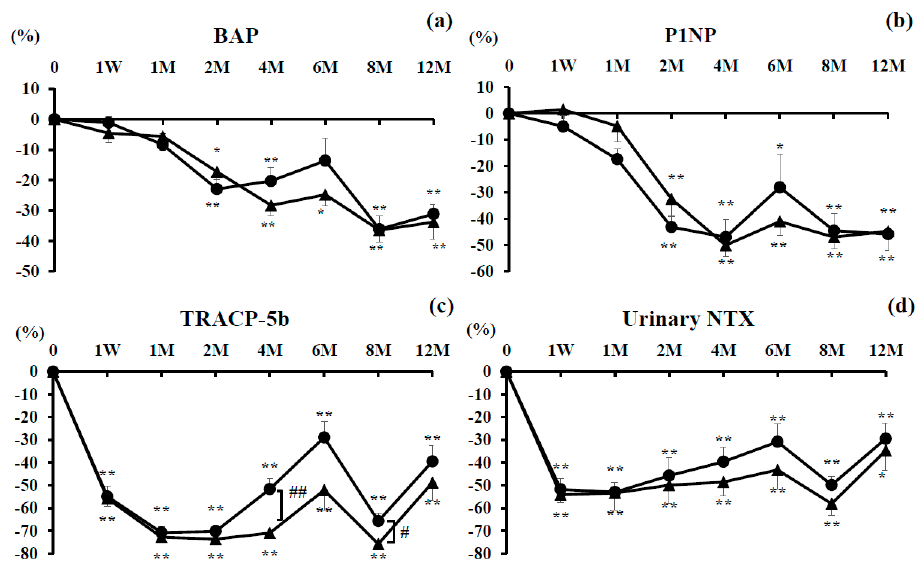
Figure 2. Percent changes of serum bone-specific alkaline phosphatase (BAP) ( a ); serum N-terminal propeptide of type 1 procollagen (P1NP) ( b ); serum tartrate-resistant acid phosphatase (TRACP)-5b ( c ); urinary cross-linked N-terminal telopeptides of type I collagen (NTX) ( d ) over the 12-month study period. Closed circles show the denosumab monotherapy group and closed triangles show the